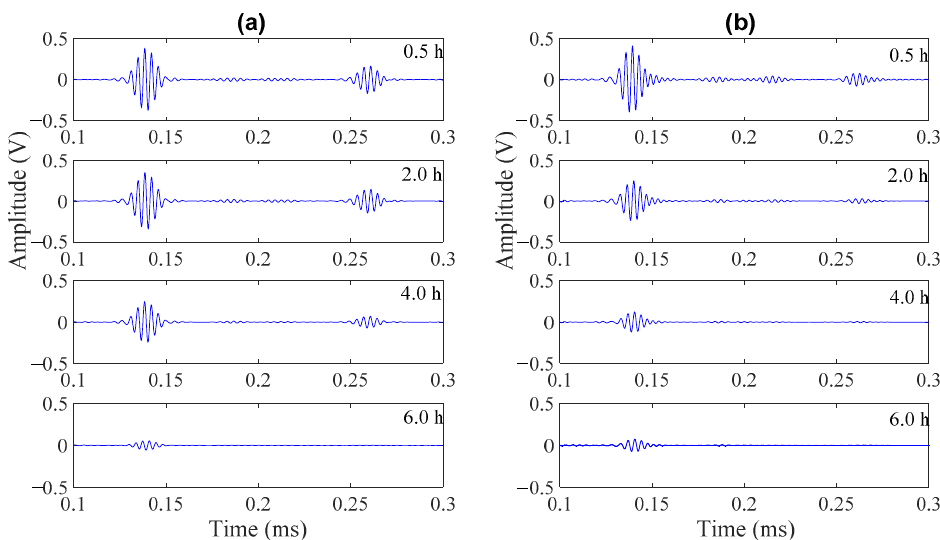
Figure 5. Waveforms at 0.5, 2.0, 4.0, and 6.0 h for a mortar sample with w/c = 0.40 using: ( a ) a steel rod of 3.17 mm diameter; ( b ) an aluminum rod of 3.17 mm diameter.